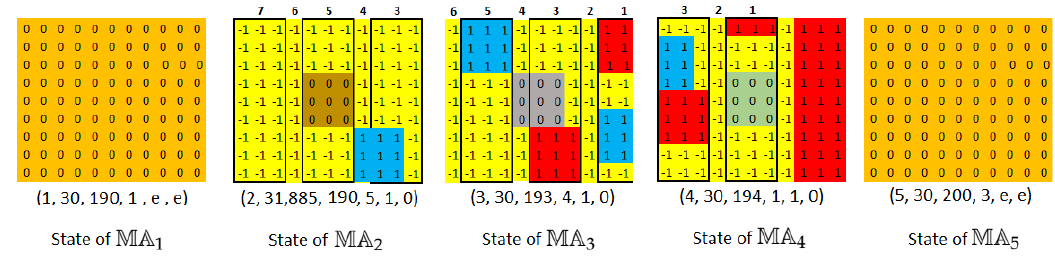
Figure 7. A new state of S MA il with the release